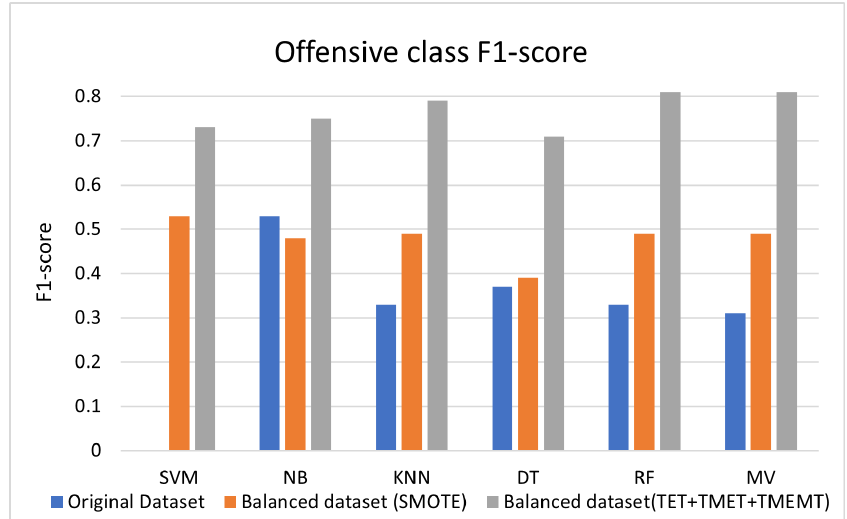
Figure 10. Offensive class F 1 -scores for original and balanced dataset (TET + TMET + TMEMT).